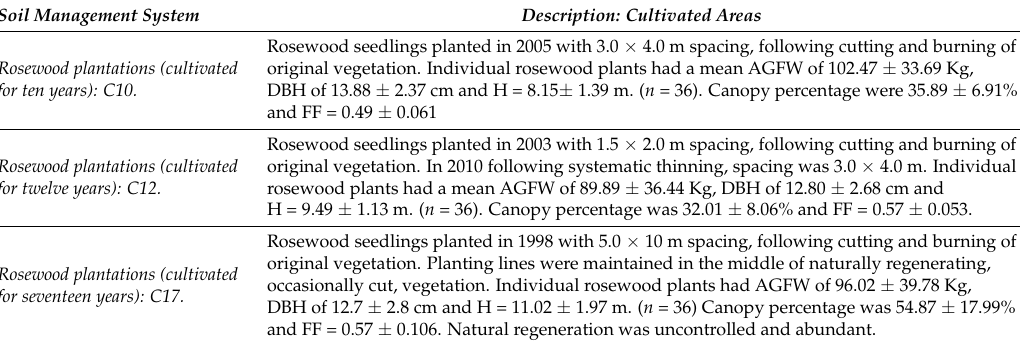
Table A1. Description of study areas showing values for: diameter at breast height (DBH) height (H), above-ground fresh weight of whole tree (AGFW), percentage of canopy fresh weight and form factor (FF) * of the trees in farmlands near Maués and Novo Aripuanã, Amazonas, Brazil. Soil Management System